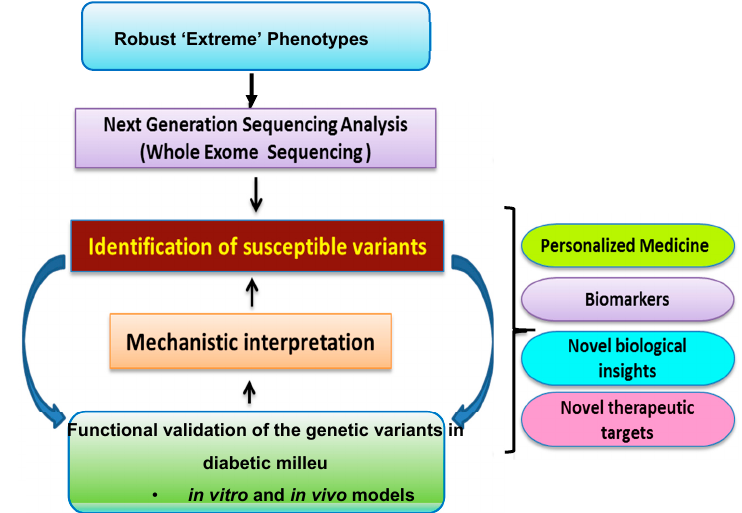
Figure 1. Schematic diagram of the experimental approach for characterizing genetic variants using next-generation sequencing (NGS).